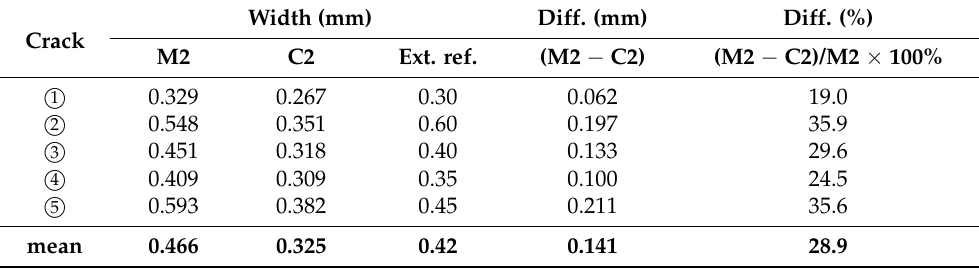
Table 3. Calculated crack widths based on strain profiles measured by monolithic sensor M2 and layered cable C2 (beam S3, load step no. 26, force = 50